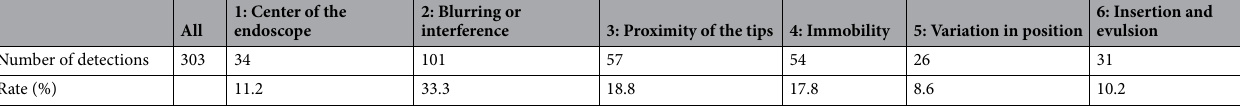
Table 3. Details of the detected erroneous parts. The details of the detected parts were confirmed with the cooperation of the expert surgeons.